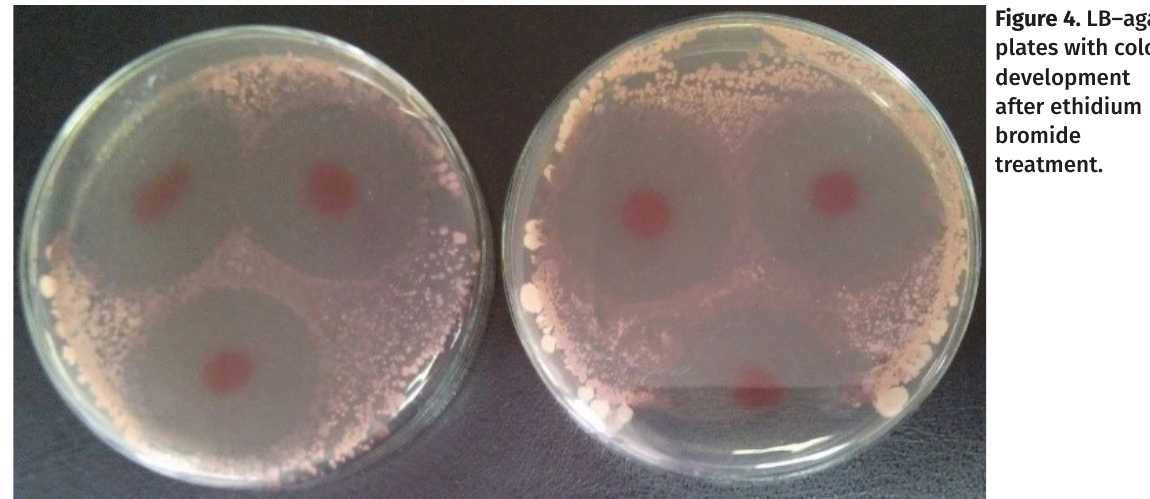
Figure 4. LB–agar plates with colony development after ethidium bromide